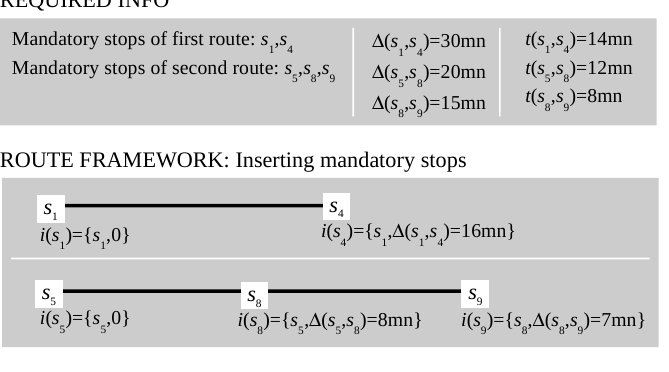
Figure 8. Algorithm illustration: inserting mandatory stops.